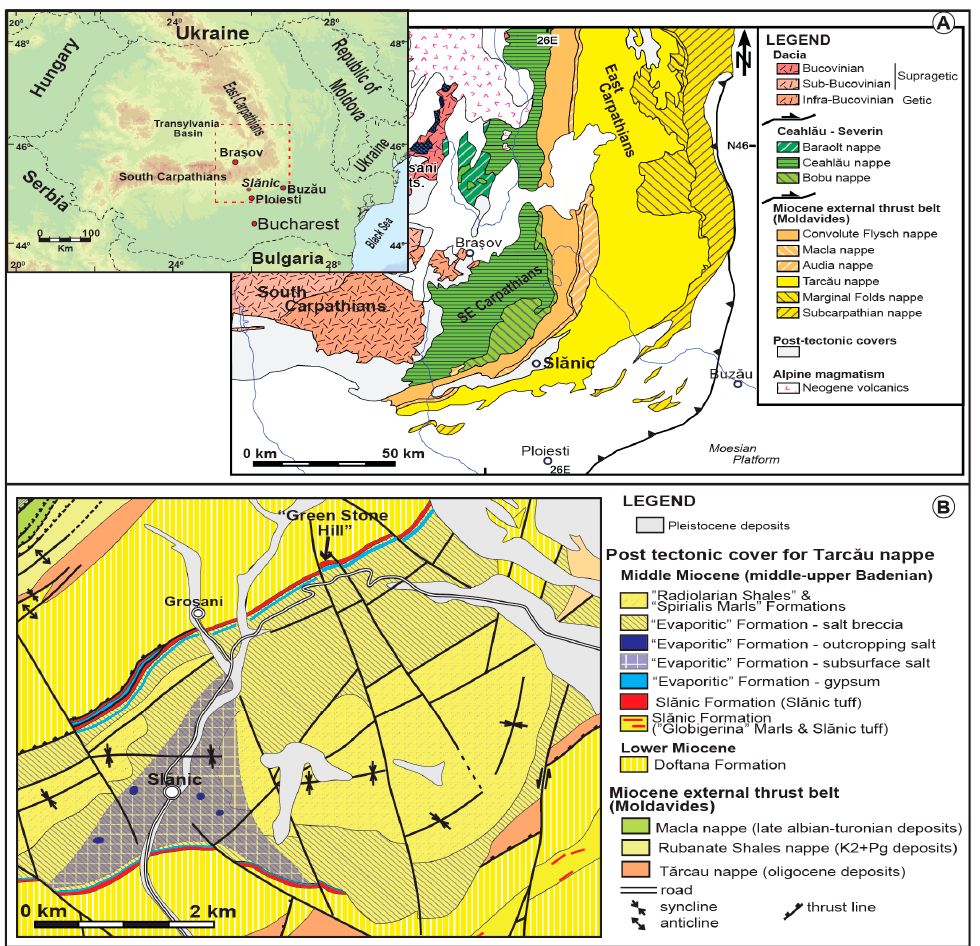
Figure 1. ( A ) Romania map with Sl ă nic Prahova location and simplified map of the SE Carpathians with location of the investigated area (after S ă ndulescu, 1984 [15]; Visarion et al., 1988 [20]; Ma ţ enco et al., 2003 [21] with modification); ( B ) Detailed geological map with the position of the investigated outcrop—Green Stone Hill (after Ş tef ă nescu et al., 1978 [22] with modification).